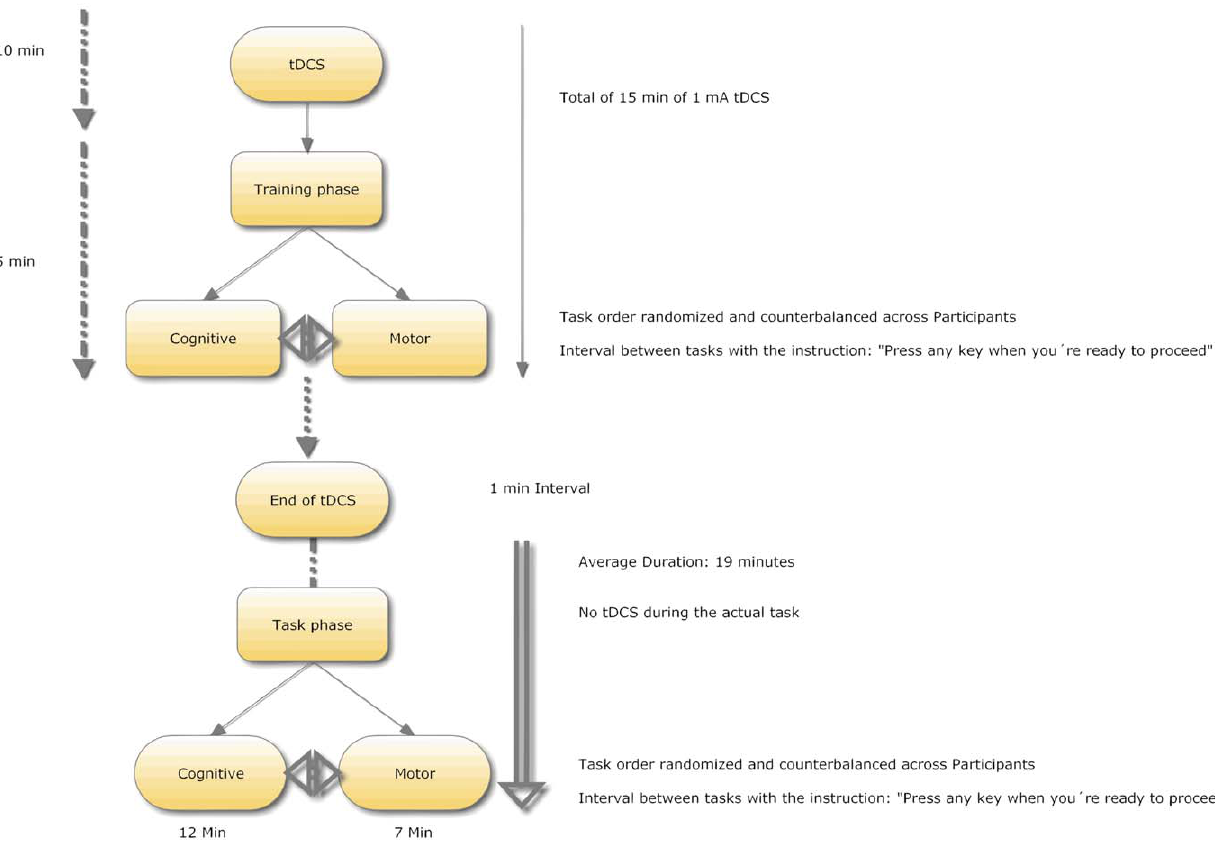
Figure 5. Schematic Representation of the experimental design used in this experiment.